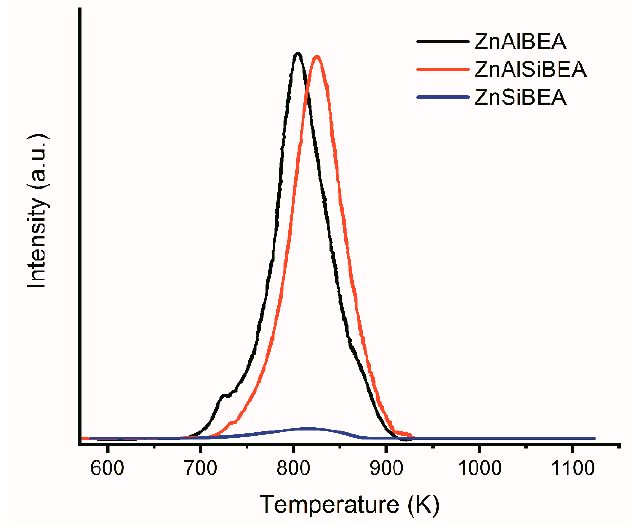
Figure 7. Normalized O 2 -TPO profiles of Zn-BEA catalysts after 2.5 h in the CO 2 -PDH reaction mixture at 923 K.